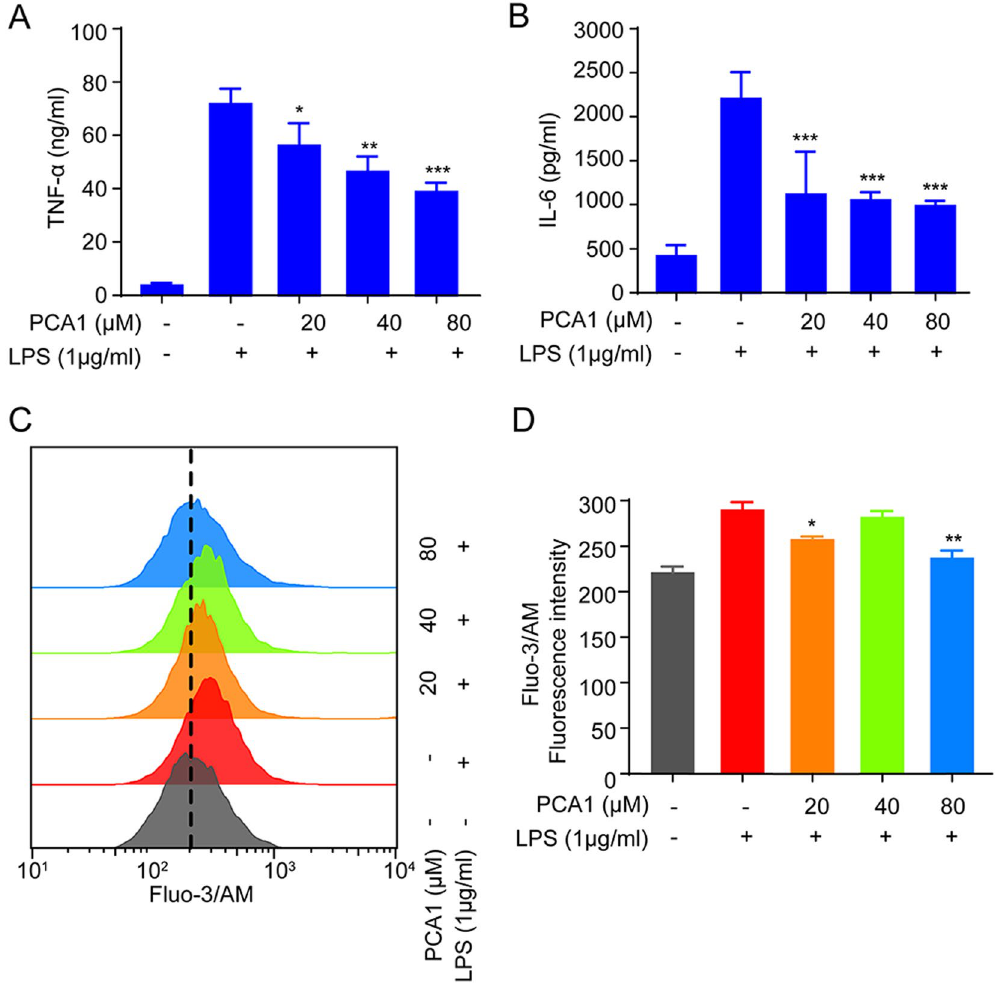
Figure 2. PCA1 reduced LPS-induced pro-inflammatory cytokines in RAW264.7 cells. ( A , B ) RAW264.7 cells treated with PCA1 (0, 20, 40, 80 μ M) for 1 h and then induced with LPS (1 μ g/ml) for 18 h. The TNF- α and IL-6 level was detected using ELISA kits. ( C ) RAW264.7 cells were pretreated with PCA1 (0, 20, 40, 80 μ M) for 1 h before co-incubation with LPS (1 μ g/ml) for 8 h. Then the cells were marked with Fluo-3/AM for 1 h and assessed by flow cytometry. ( D ) Statistical analysis of the NO per group. * p < 0.05, ** p < 0.01, and *** p < 0.001 versus the LPS